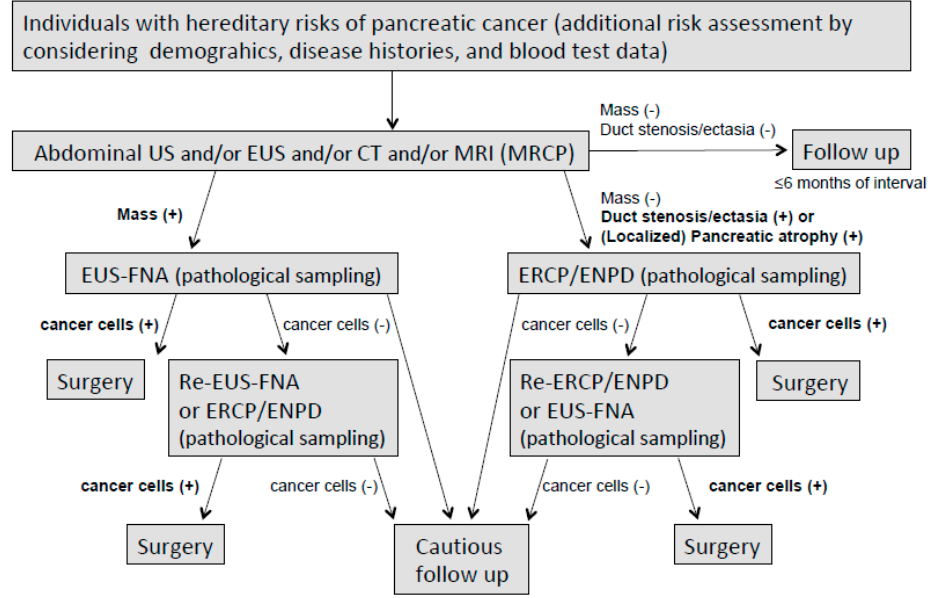
Figure 1. Proposal of surveillance and investigation of individuals with inherited risks of pancreatic cancer.